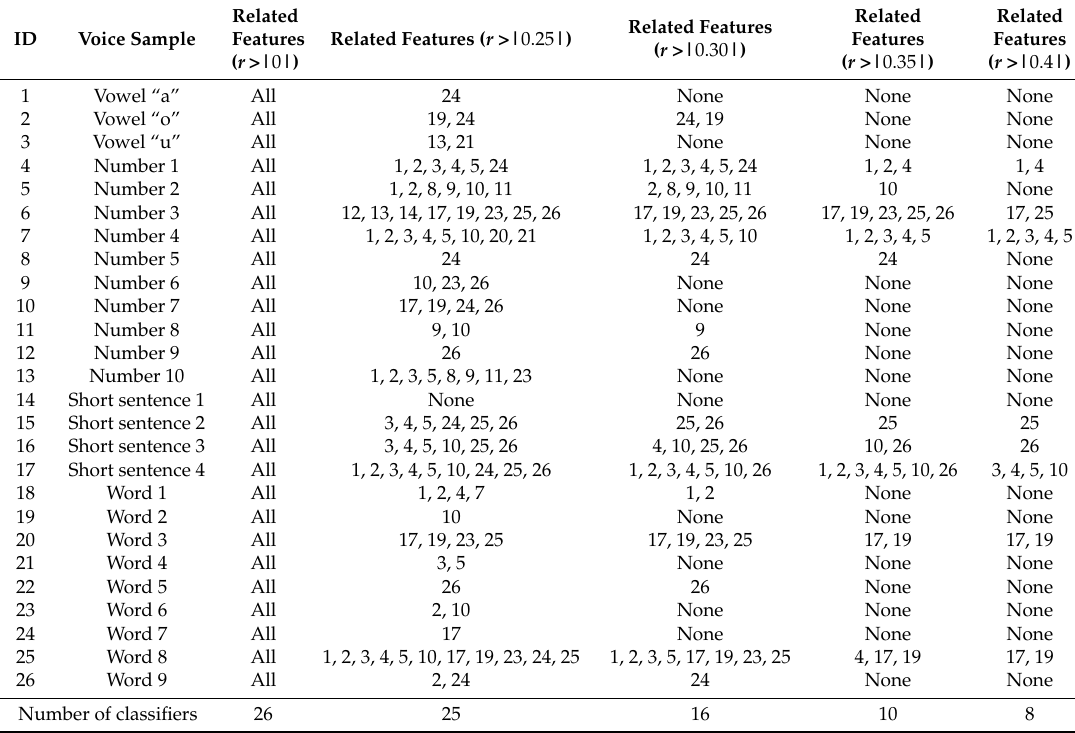
Table 3. Selected time frequency-based features using selected Pearson’s correlation factors in the case of testing multiple artificial neural networks (ANNs) on subject no. 1, and training of ANNs is performed on the other 39